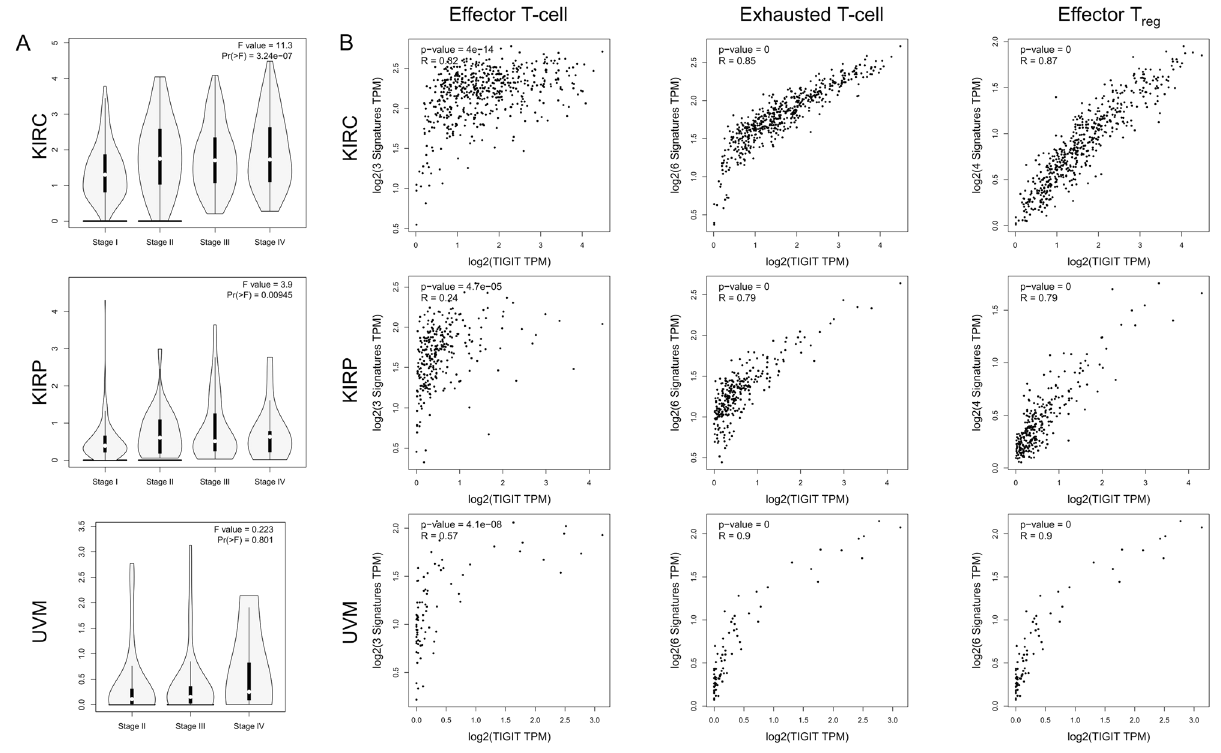
Figure 3. The correlations of TIGIT with pathological stages ( A ) and the signatures of effector T cells, exhausted T cells and effector T regs ( B ) in KIRC, KIRP, UVM by GEPIA2